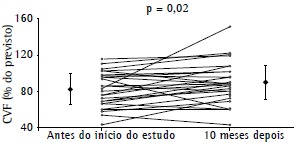
CVF (% do previsto) antes do início do estudo e 10 meses depois. Nota-se
que a CVF estava significativamente maior 10 meses depois. Os losangos
representam média ± dp.